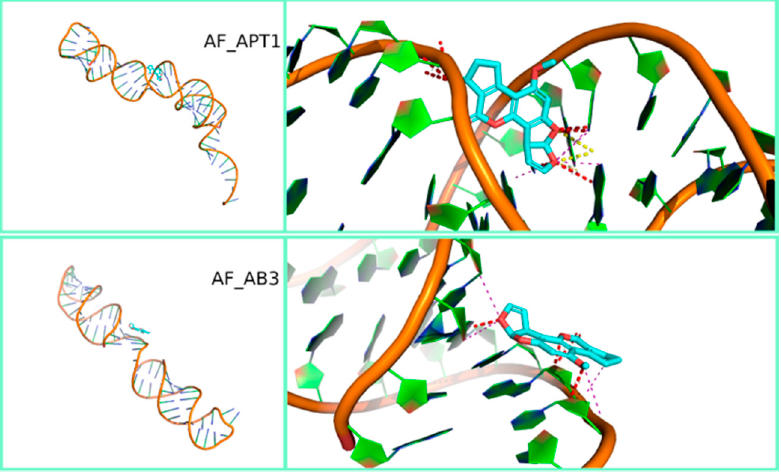
Figure 4. Three-dimensional representation of the best-docked pose of the two aflatoxins B1 aptamers (AF_APT1 and AF_AB3). Full view on the left and zoom with contact maps on the right.